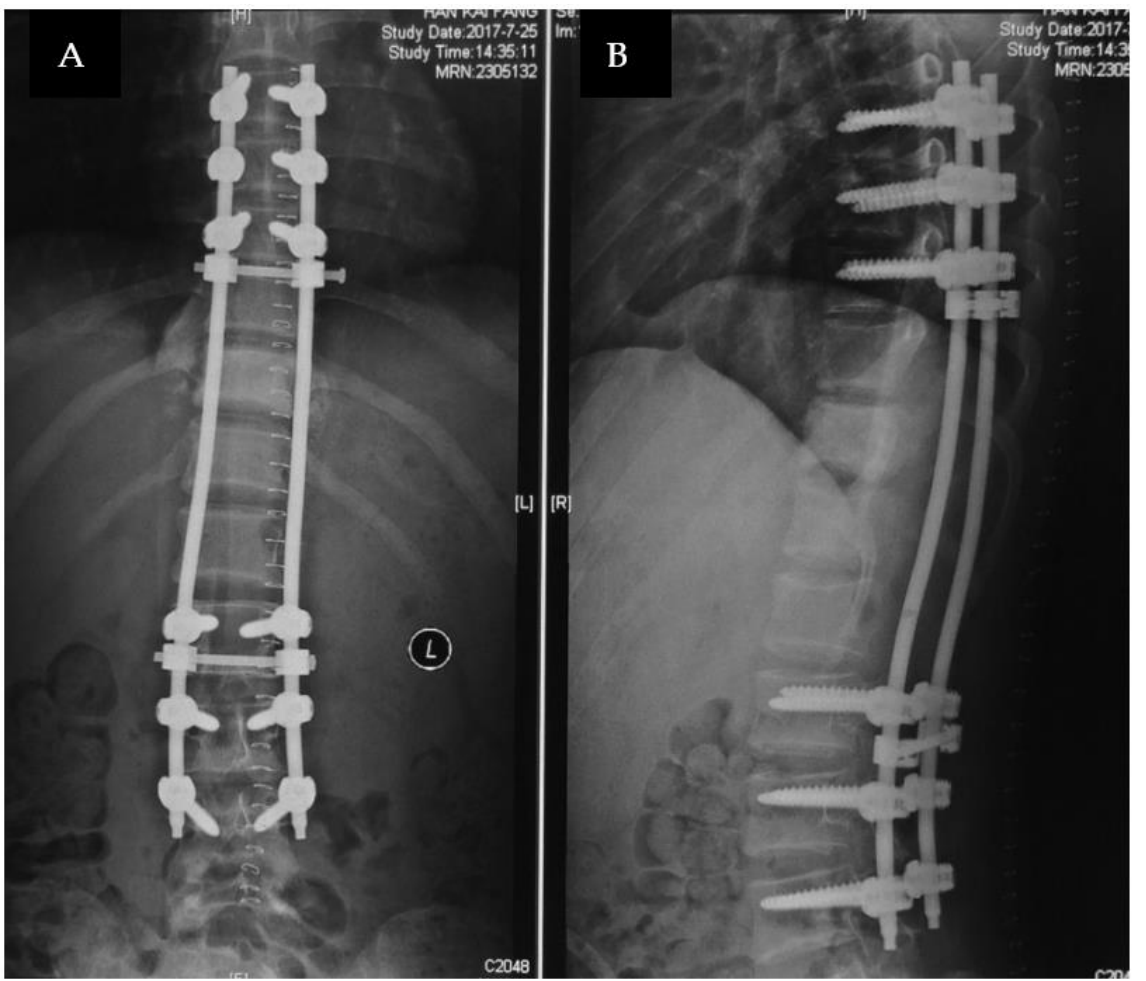
Figure 5. Anterior − posterior ( A ) and lateral X-ray ( B ) after palliative decompression surgery of the patient with CMF-OS.